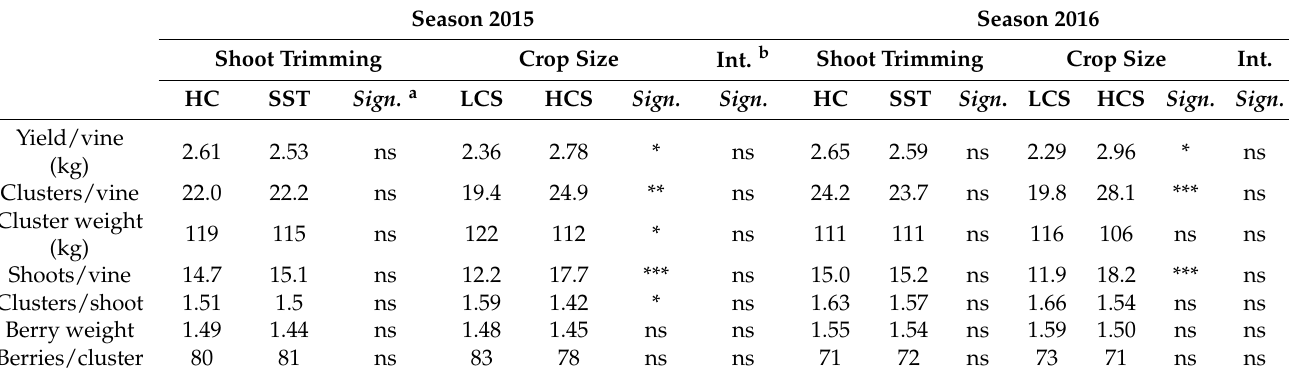
Table 5. Yield components of Merlot grapevines subjected to two different trimming heights (HC, high canopy and SST, severe shoot trimming) and two different crop sizes (LCS, low crop size and HCS, high crop size).